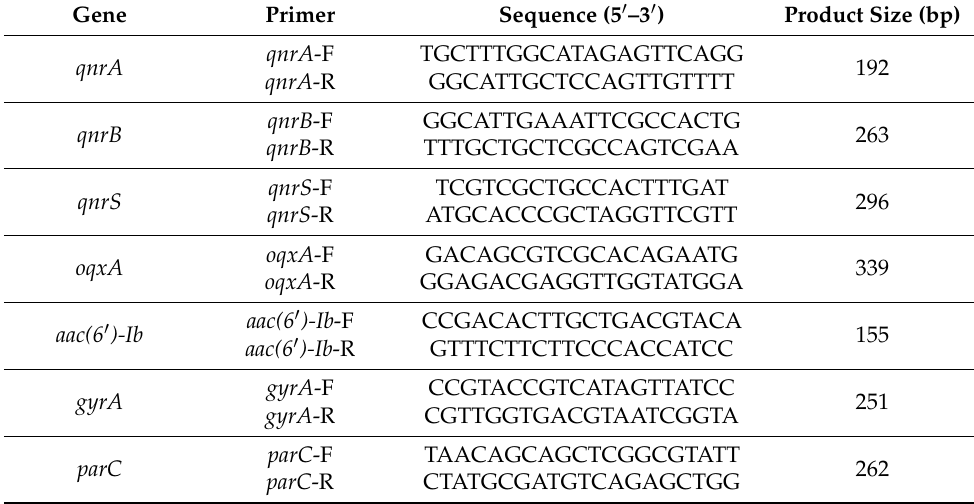
Table 2. qPCR primers for the target